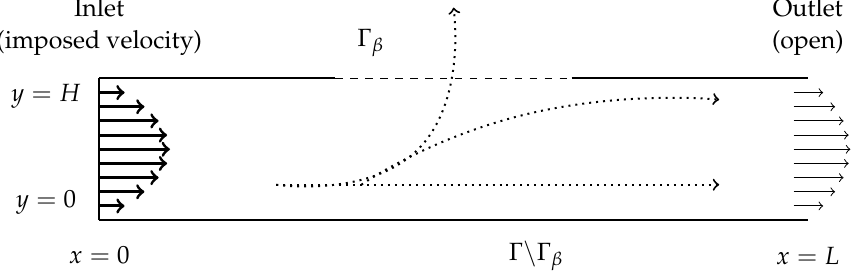
( 1 − y ) for 0 ≤ y ≤ H enters the H H